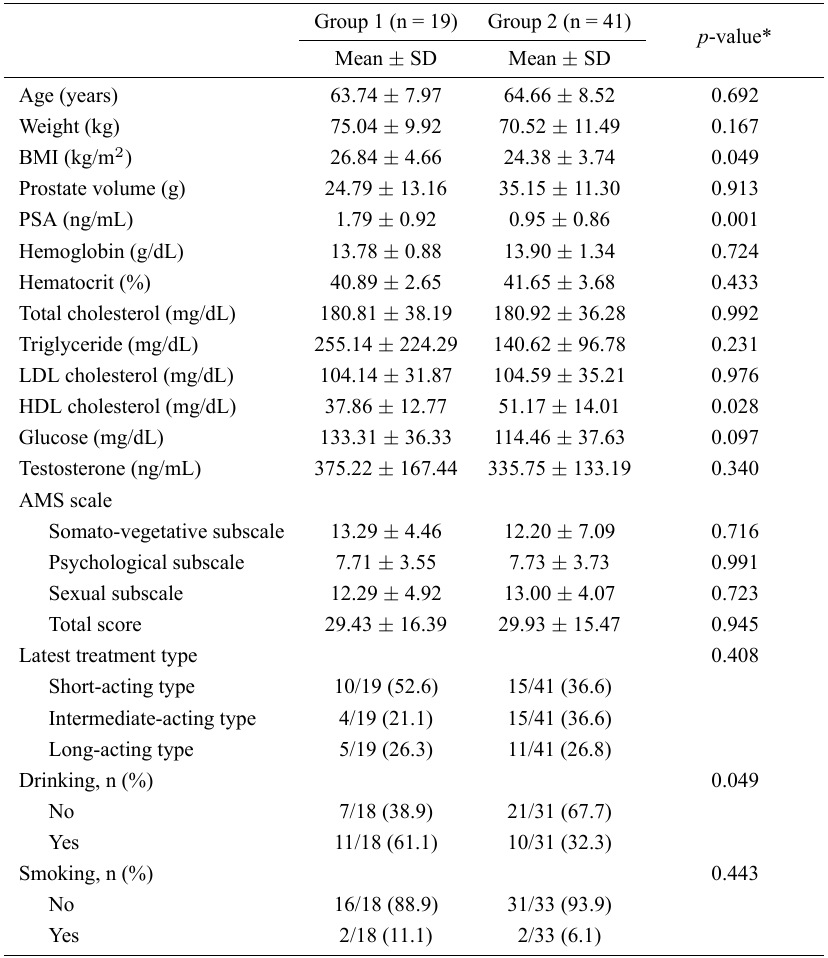
Table 3. Comparison of baseline medical and demographic characteristics between the prostate biopsy (Group 1) and the non-prostate biopsy group (Group 2).